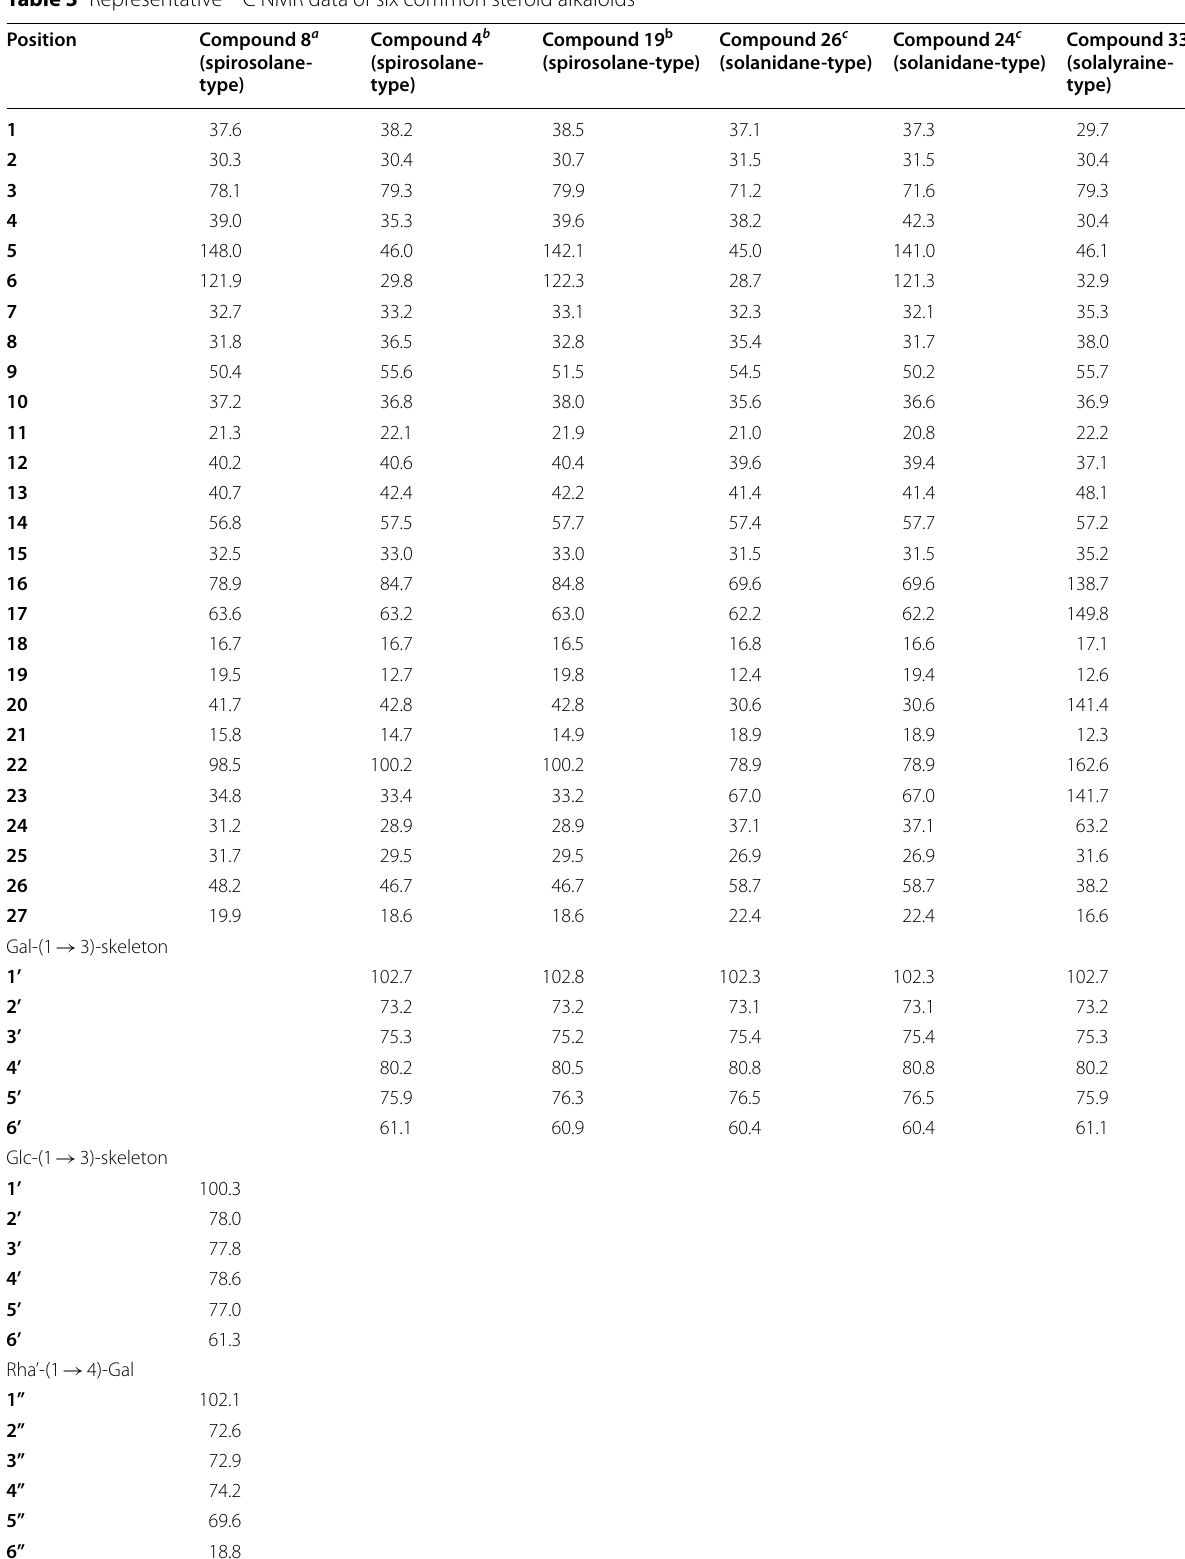
Table 3 Representative 13 C NMR data of six common steroid alkaloids